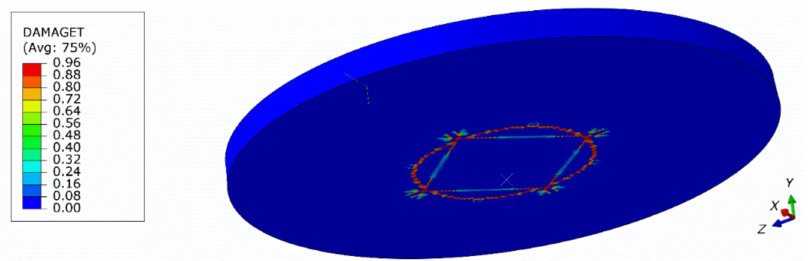
Figure 18. Contour plot of the tension damage parameter ( d t ) after failure (3D model, global mesh size: 3